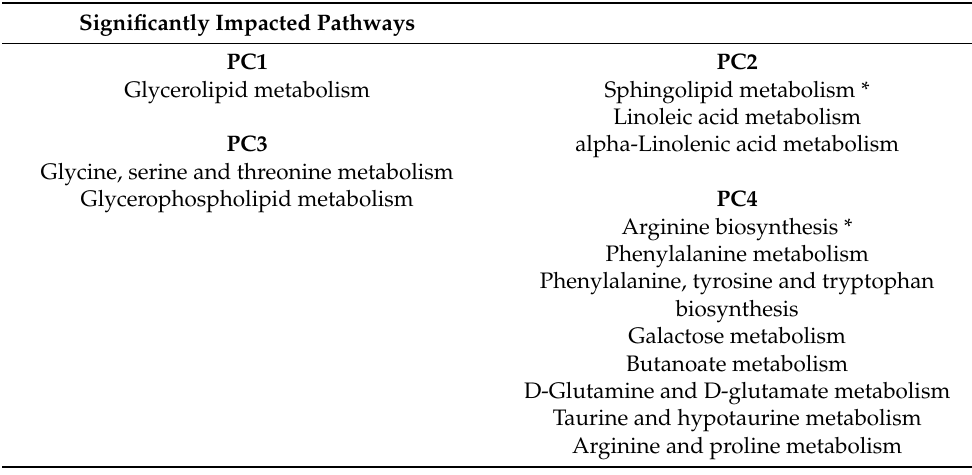
Table 3. Metabolic pathways represented in the first four components identified with